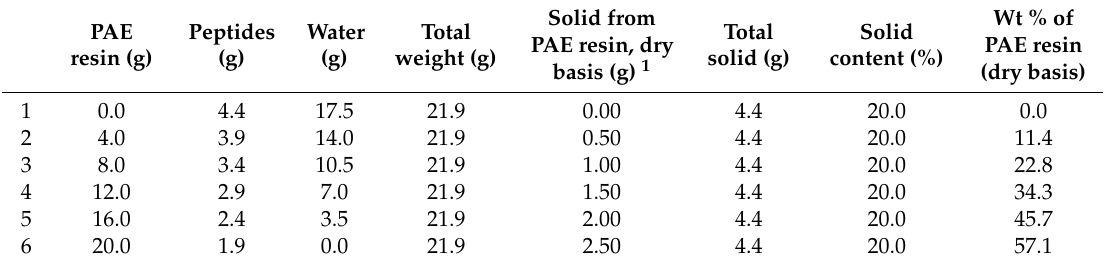
Table 1. Formulation of peptides–PAE adhesive by varying the ratio of peptides and PAE